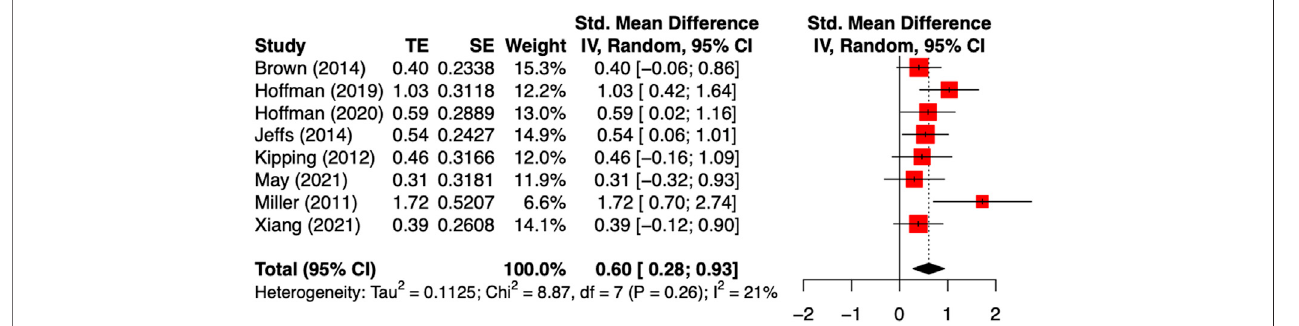
FIGURE 2 | Met-analysis of the effect of VR on self-reported pain intensity during the wound care. The combined effect size was moderate Cohen ’ s d (cid:1) 0.60 with non-signi fi cant between study heterogeneity.